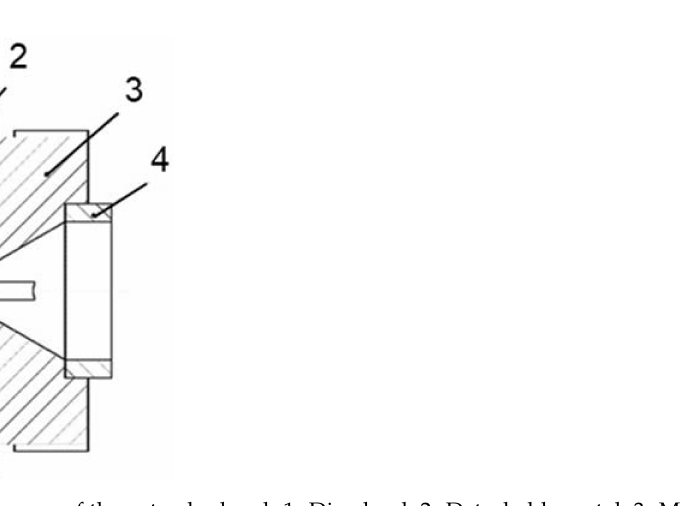
Figure 3. Schematic diagram of the extruder head: 1. Die gland; 2. Detachable metal; 3. Machine head body; 4. Perforated